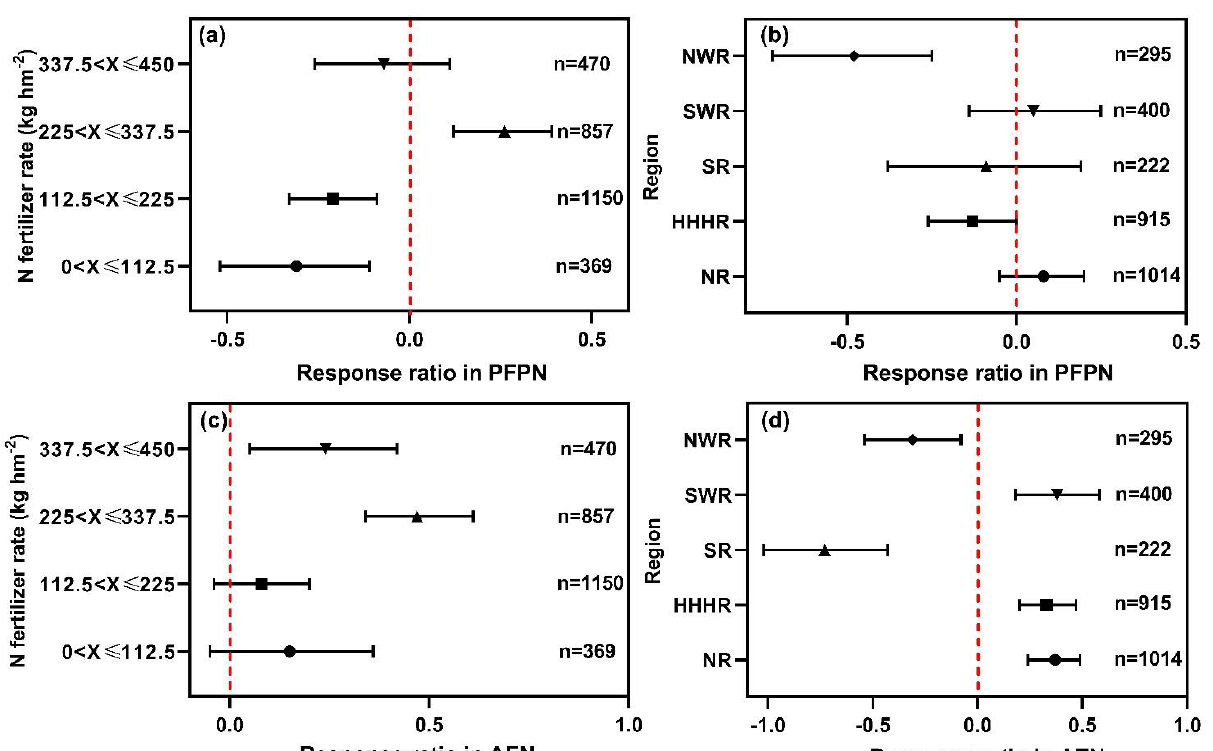
Figure 5. The effects of the period (2012–2018 versus 2005–2011) on maize PFPN and AEN at each N fertilization level ( a , c ) and in each region ( b , d ). NR: Northern region; HHHR: Huang-Huai-Hai region; SR: Southern region; SWR: Southwest region; NWR: Northwest region; PFPN: partial factor productivity of N; AEN: agronomic efficiency of N. The error lines indicate the 95th percentile bootstrap confidence intervals, whereas the n values indicate the corresponding number of observations (total number of control and treatment values). The PFPN and AEN values of the 2012–2018 period were the treatment values, whereas the PFPN and AEN values of the 2005–2011 period were the control